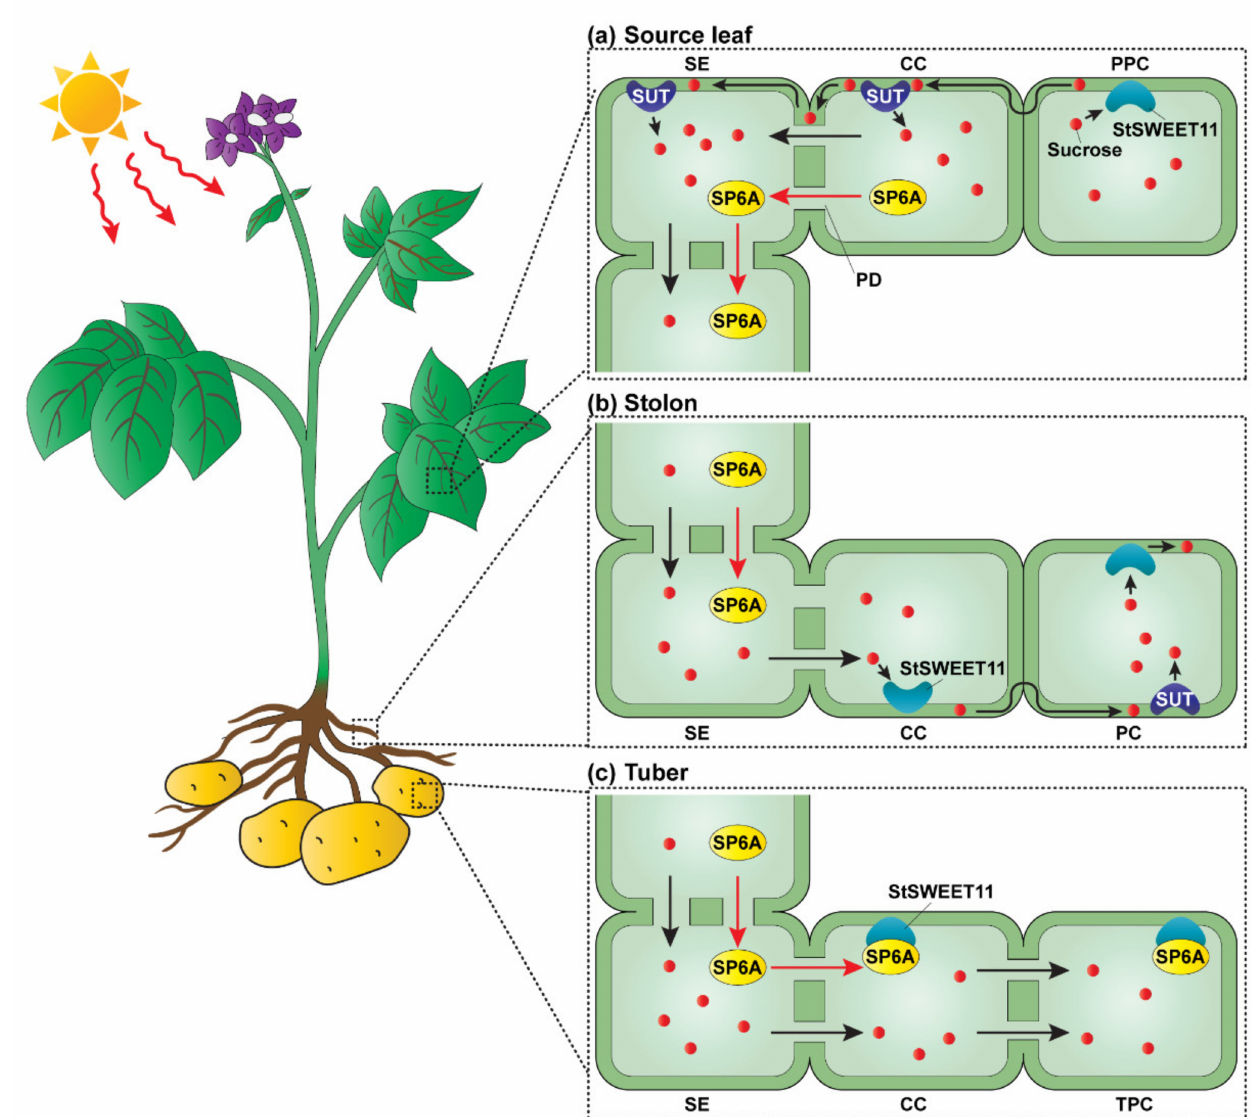
Figure 4. Mobile SP6A mediates StSWEET11 function in potato tuberization. ( a ) Sucrose is trans- ported from phloem parenchyma cells (PPC) to companion cells (CC) in the source leaves, using the apoplasmic pathway. Sucrose transporters (SUTs) load sucrose into sieve elements (SEs) and CCs to establish a high concentration in the phloem. Sucrose also can move symplasmically from CCs to SEs through plasmodesmata (PD). High levels of sucrose promote SP6A expression in CCs of source leaves; PD-mediated intercellular movement of SP6A allows its long-distance trafficking through the phloem. ( b ) In the stolon, sucrose moves symplasmically from SEs to CCs where it is then unloaded, via the StSWEET11 permease, into the apoplasm. Sucrose is retrieved from the apoplast of parenchyma cells (PCs) by the SUTs. ( c ) Under tuberization, shoot-derived SP6A is unloaded into the stolon CCs where it interacts with StSWEET11 permeases to block apoplasmic sucrose transport between CCs and tuber parenchyma cells (TPCs); thereby, sucrose moves symplasmically from CCs to TPCs. The transition of sucrose unloading pathway in TPCs, from apoplasmic to symplasmic, facilitates tuberization process under high availability of sucrose. Red small round circles indicate sucrose